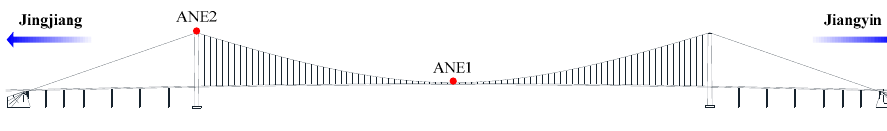
Figure 1. Layout of anemometers on Jiangyin Bridge.